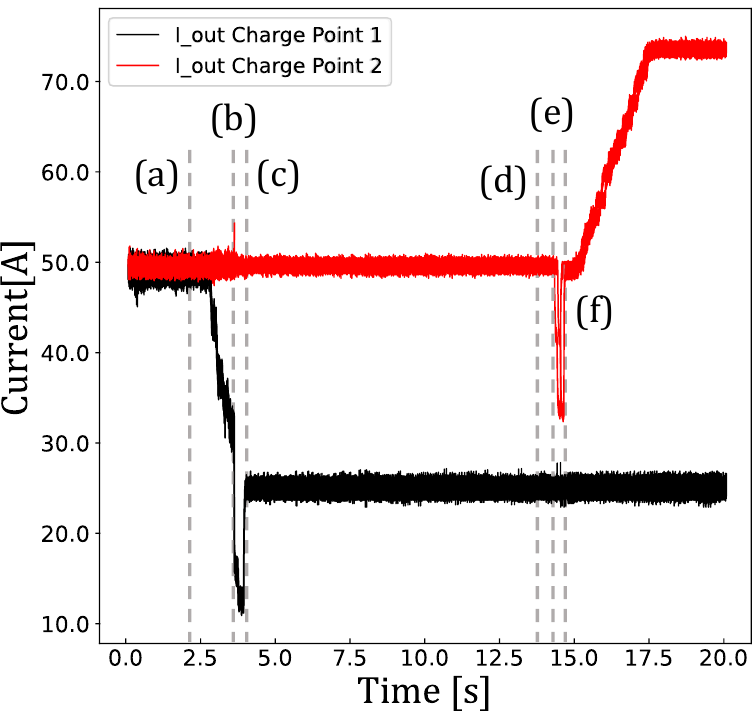
Figure 6. Switching of one Converter Module. (a) Relay Turn off Request, (b) Relay Turn off, (c) Current Limit Adjustment, (d) Relay Turn on Request, (e) Relay Turn on and (f) Current Limit